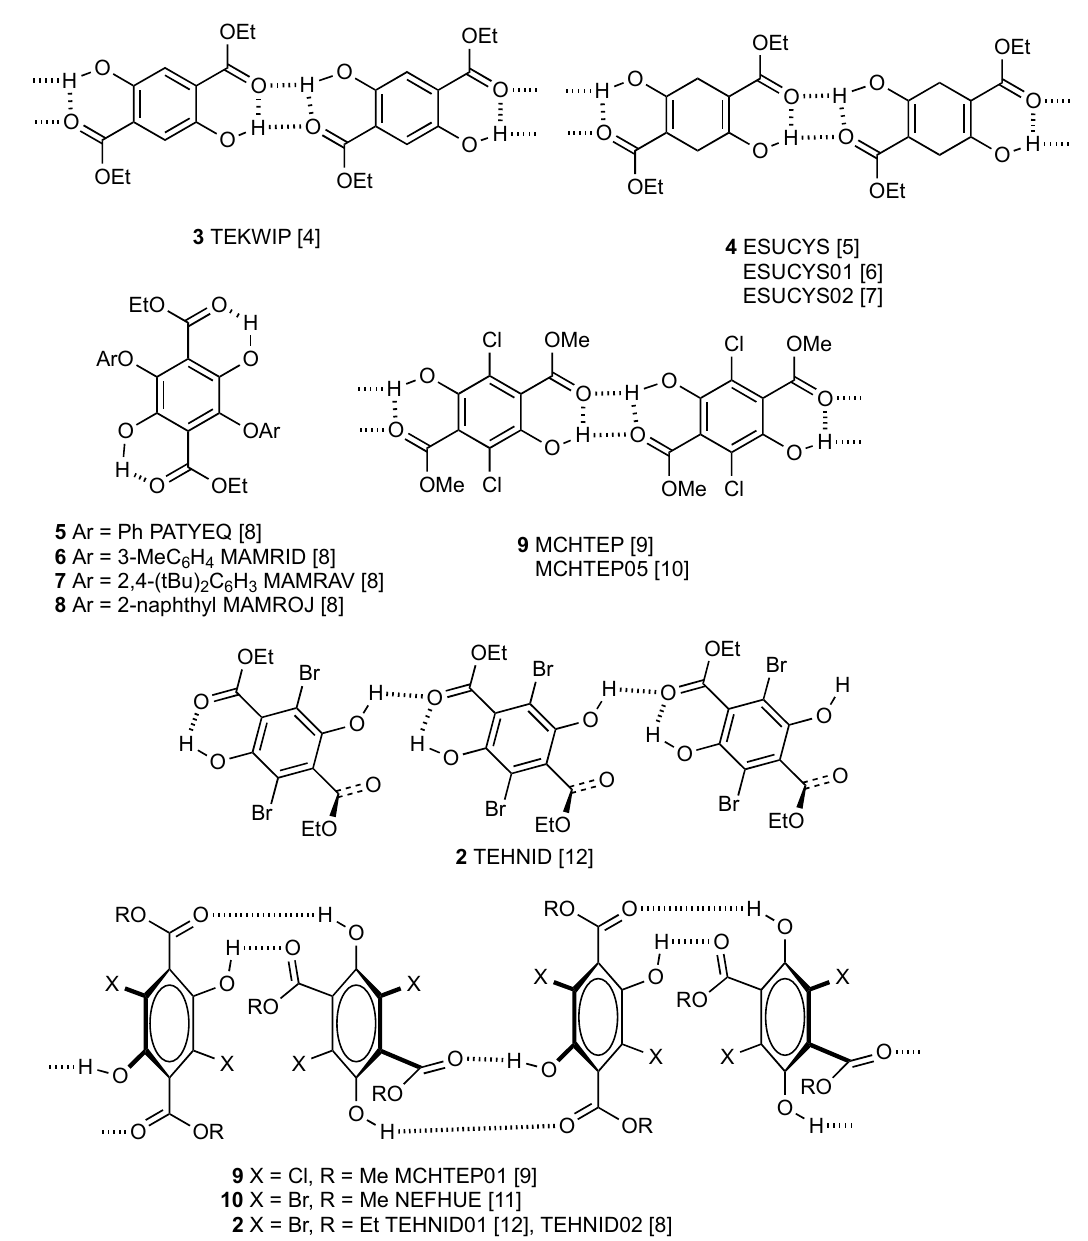
Figure 4. Reported X-ray structures of dihydroxyterephthalates and substituted derivatives [4–12].